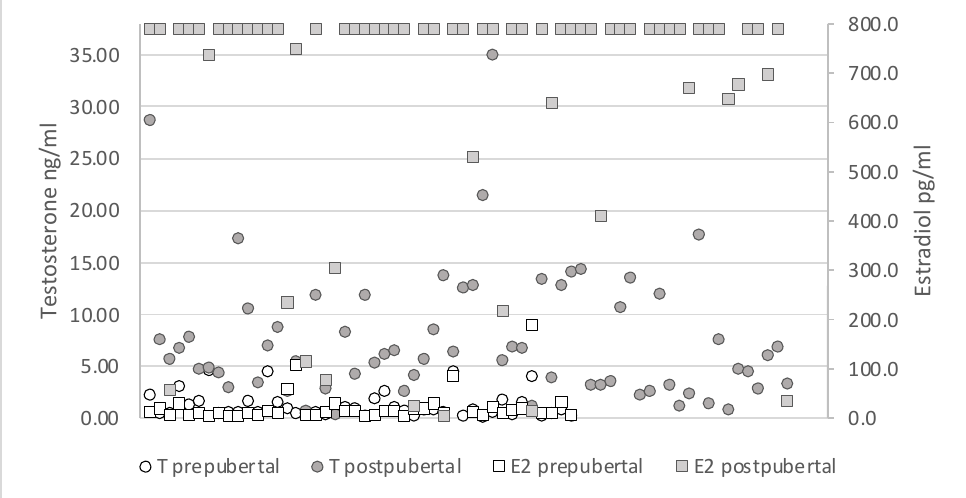
Figure 3. Overview of T and E2 levels of pre- and postpubertal wild boar males based on the defi- nition chosen in this study. T concentrations are marked with dots and E2 with squares, respectively. Almost all prepubertal T and E2 values are concentrated on the lower limit, whereas T values of postpubertal males are distributed at higher concentrations. E2 in postpubertal males reached the upper detectable limit of the radioimmunoassay.